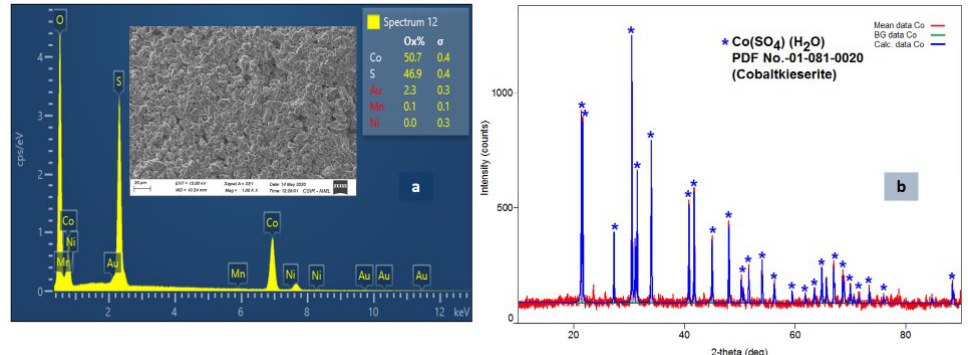
Figure 7. Characterisation of Cobalt sulfate product ( a ) SEM; ( b )